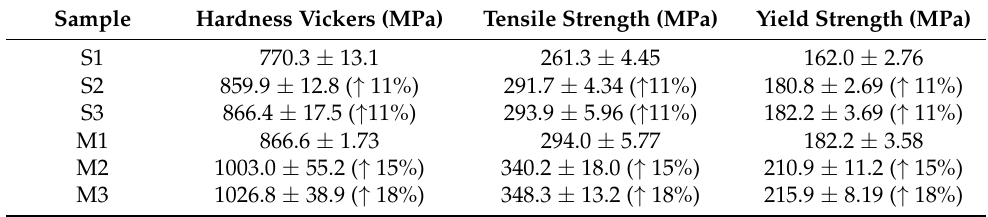
Table 3. Hardness, tensile, and yield strength values of SPS thermally treated Al samples reinforced with SWNCTs (S1–S3) and MWCNTs (M1–M3) with 0.5 wt%, 1 wt%, and 2 wt%,